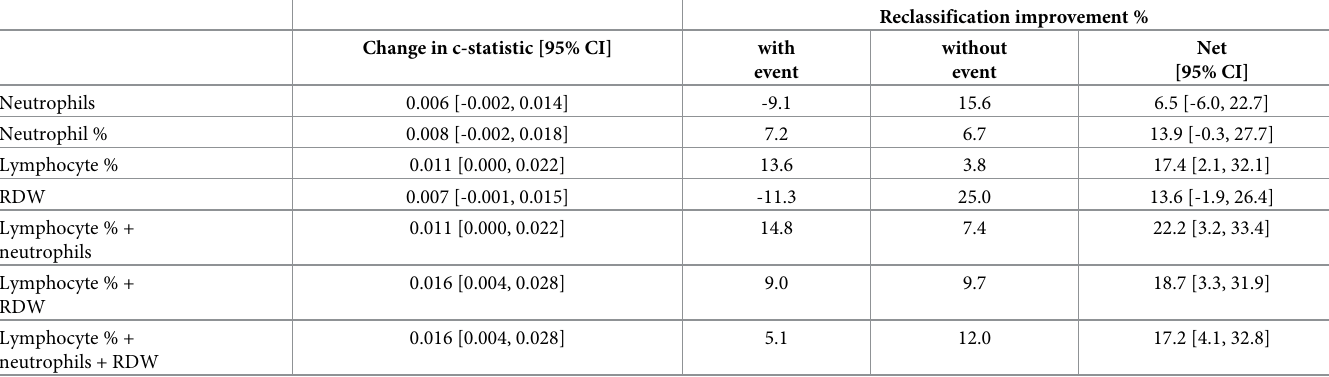
Lymphocytes have been implicated in the modulation of inflammatory processes at distinct stages of atherogenesis [15]. Numerous observational studies in patients with coronary artery disease have reported associations of low absolute and relative lymphocyte levels with poor Table 3. Predictive performance of hematological